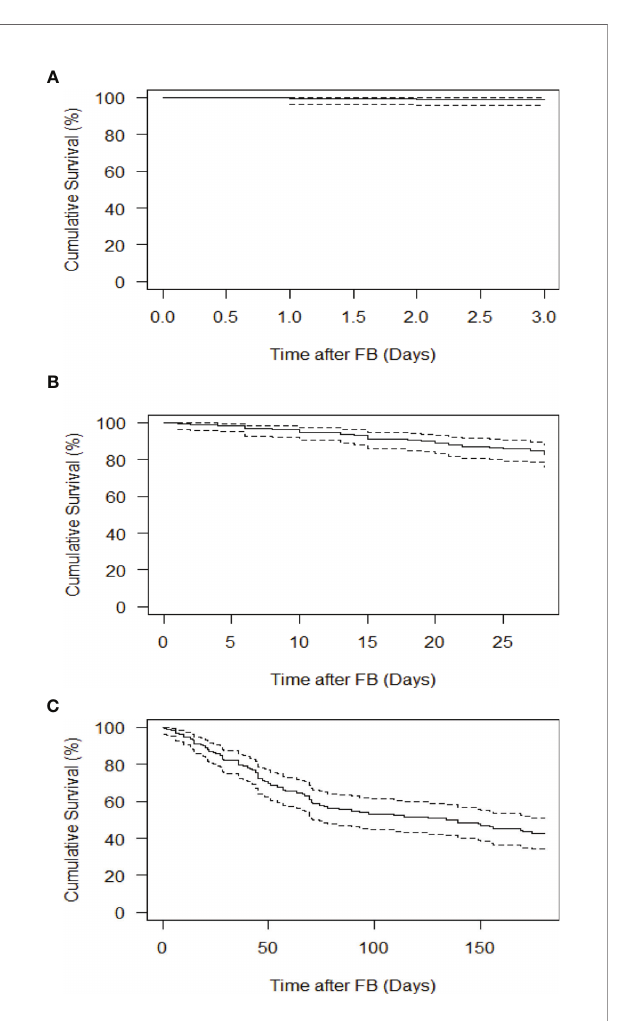
FIGURE 1 | Survival of pediatric and AYA patients undergoing FB. (A) 3 day survival. (B) 28-day survival. (C) 180 day survival. Solid lines indicate the Kaplan-Meier survival curve, while dashed lines indicate 95% con fi dence